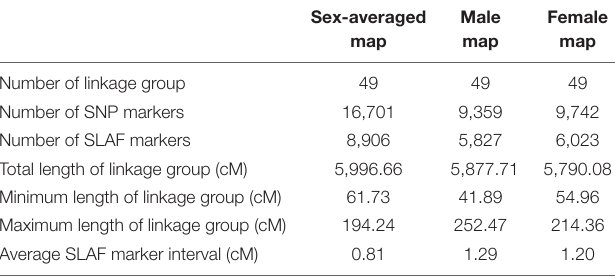
TABLE 1 | SLAF-seq data statistics in Scylla paramamosain . TABLE 2 | Summary of Scylla paramamosain linkage